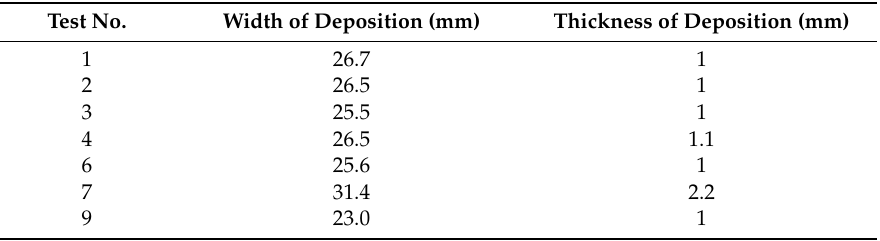
Table 4. Deposition width and